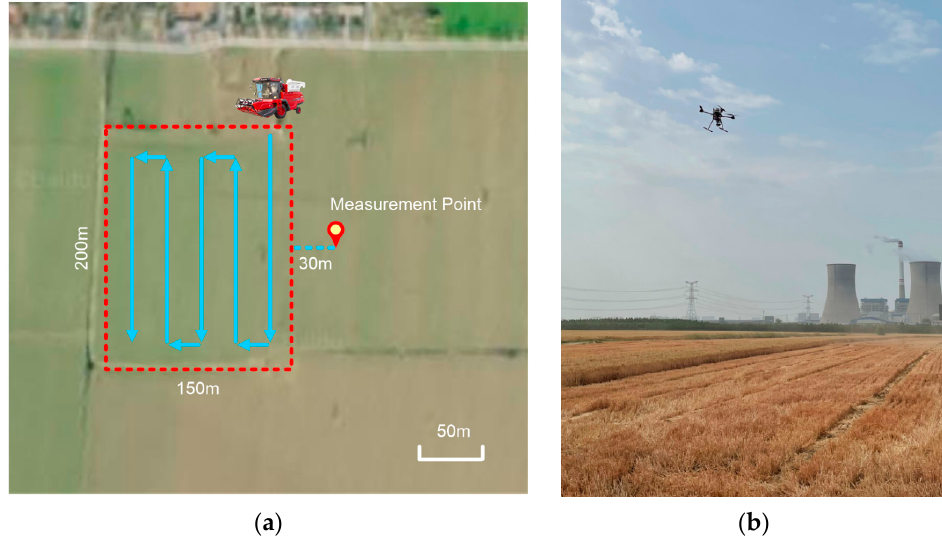
Figure 14. Agri-environmental measurement experimental site: ( a ) setting of measurement point; ( b ) the drone performing flight measurement work.